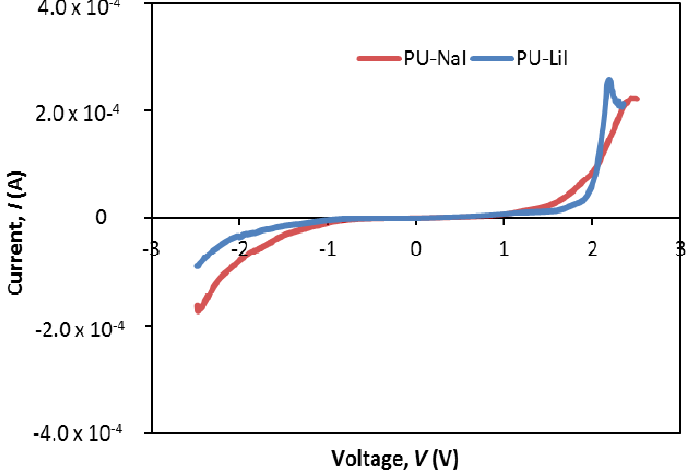
Figure 6. Linear sweep voltammograms of PU-LiI and PU-NaI polymer electrolyte